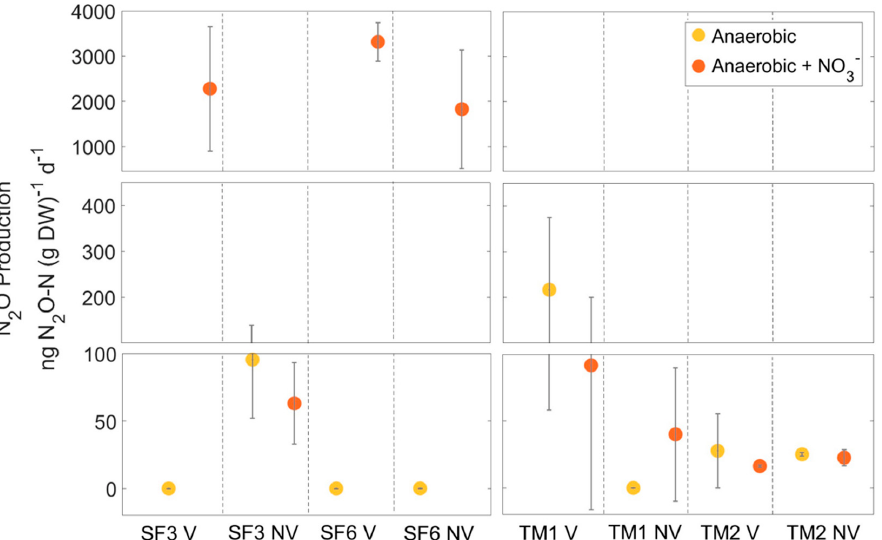
Figure 3. Mean anaerobic N 2 O production before (yellow) and after nitrate addition (152 mM) (orange) from revegetated (V) and non − vegetated (NV) slump floor (SF, left ) and thaw mound (TM, right ) soils (at 4 ◦ C). Whiskers indicate standard deviation. For a better visualization the y–axis is